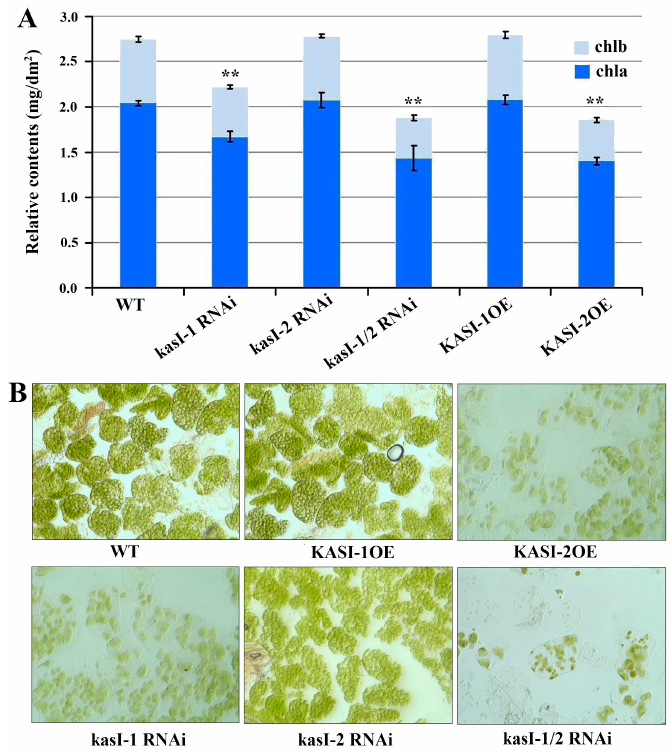
Figure 7. Measurement of chlorophyll content: ( A ) content of chlorophyll a and b (mg/dm 2 fresh weight) measured in 8th, 9th and 10th leaves at four month after germination. The asterisks above the bar represent significant differences in content of chlorophyll a and b between transgenic lines and WT (** p < 0.01). Error bars represent the standard errors with four biological replications; ( B ) Morphological observation of chloroplast in leaves of WT and all transgenic lines.